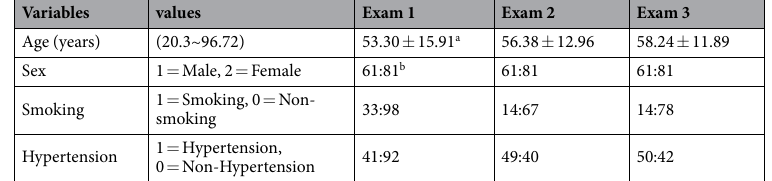
Variables values Exam 1 (20.3~96.72)